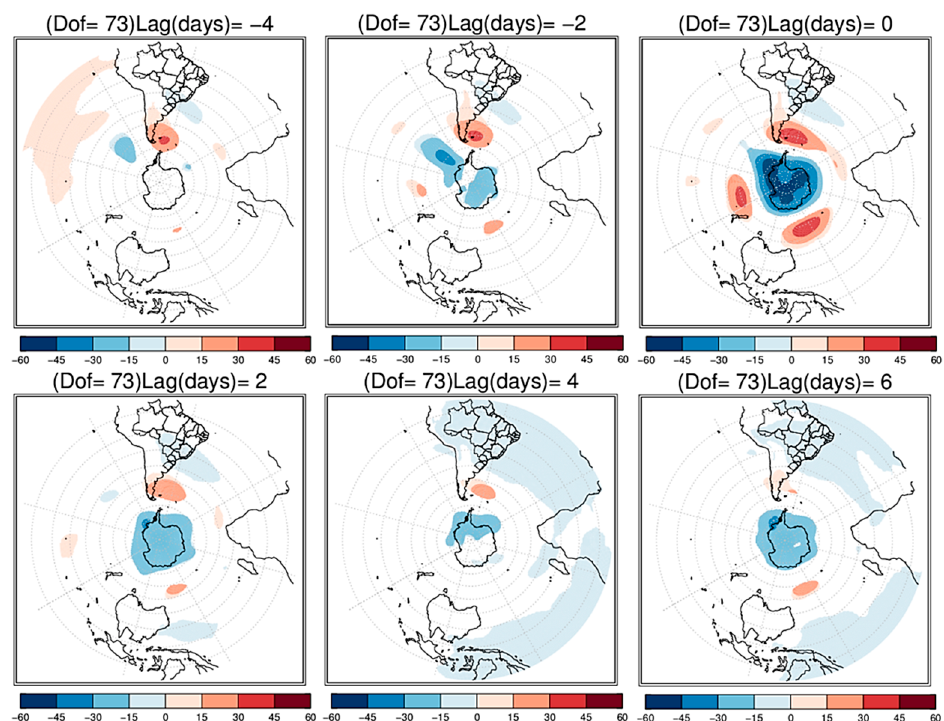
Figure 10. Lag composite of geopotential height anomalies (m) at 700 hPa during SACZ events at AAO+. Shaded areas in red (blue) are for the positive (negative) values statistically significant at the 5% level, based on Student’s t -test. Dof is the degrees of freedom.